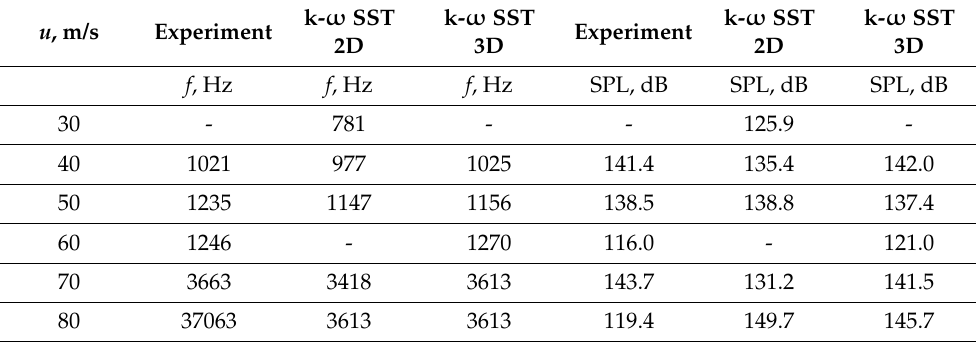
Table 2. Parameters of the generated acoustic wave for the velocity range 30–80